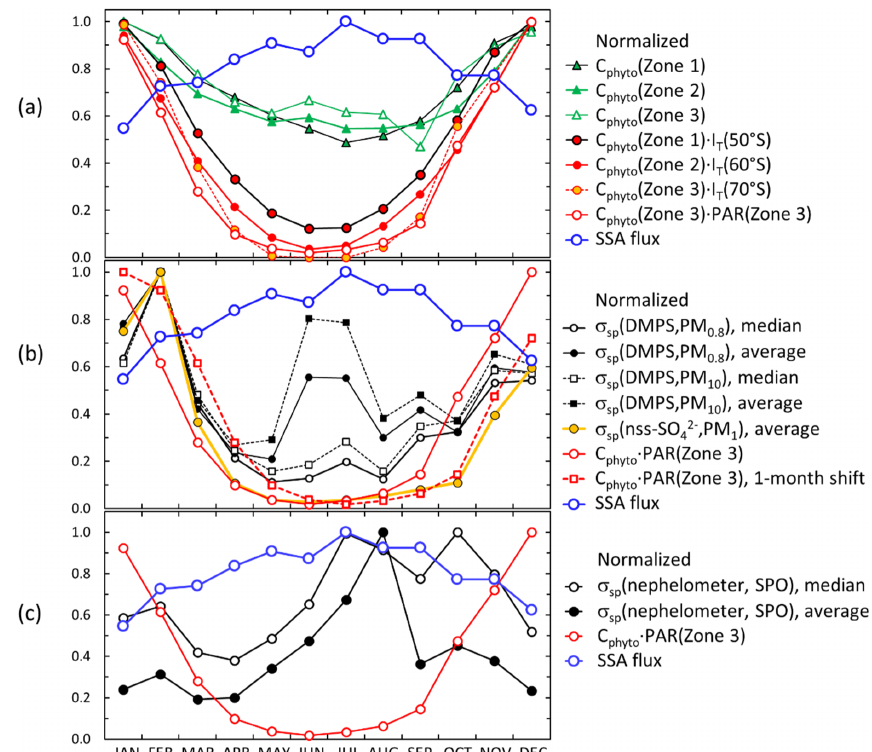
Figure 17. Normalized seasonal cycles of (a) major natural sources of light-scattering aerosols from the oceans, (b) scattering coefficients at Dome C, and (c) scattering coefficients at the SPO. σ sp (DMPS,PM 0 . 8 ) and σ sp (DMPS,PM 10 ): scattering coefficient calculated from particle number size distributions; σ sp (nssSO 2 − ,PM 1 ): scattering coefficient calculated from non-sea-salt sulfate concentrations in PM 1 4 filter samples; σ sp (nephelometer, SPO): scattering coefficient measured with the nephelometer at the SPO; C phyto : phytoplankton biomass concentration in 2008–2013 calculated as monthly averages from the time series presented by Behrenfeld et al. (2016) using CALIOP satellite data in Zone 1 (45–55 ◦ S), Zone 2 ( − 65 ◦ S), and Zone 3 (65–75 ◦ S); I T (50 ◦ S), I T (60 ◦ S), and I T (70 ◦ S): average global radiation at latitudes 50, 60, and 70 ◦ S at longitude 0 ◦ at 10:00–14:00UTC; PAR (Zone 3): photosynthetically active radiation from Behrenfeld